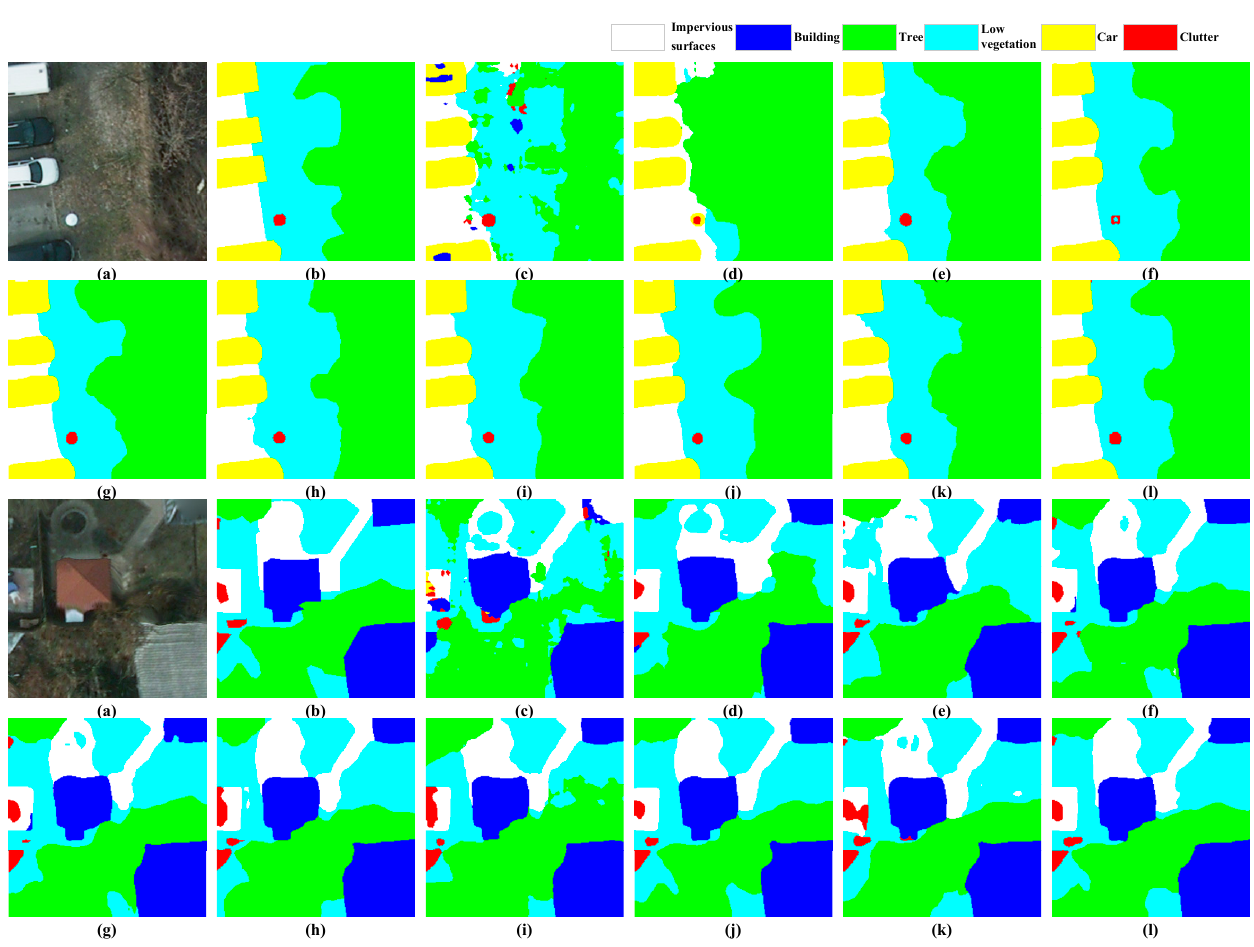
Figure 9. Visualizations of predictions of the test set of the ISPRS Potsdam benchmark. ( a ) Input image, ( b ) ground truth, ( c ) FCN-8s, ( d ) SegNet, ( e ) U-Net, ( f ) DeepLab V3+, ( g ) CBAM, ( h ) DANet, ( i ) ResUNet-a, ( j ) SCAttNet, ( k ) HCANet, ( l )